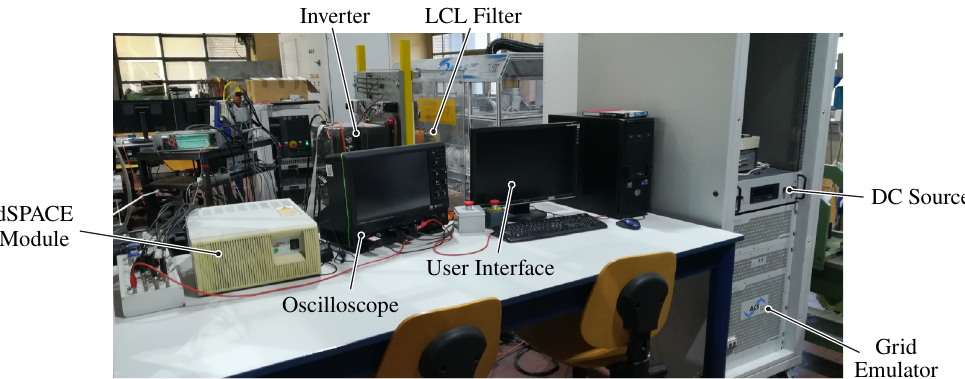
Figure 11. Adopted experimental setup for the validation of the proposed control